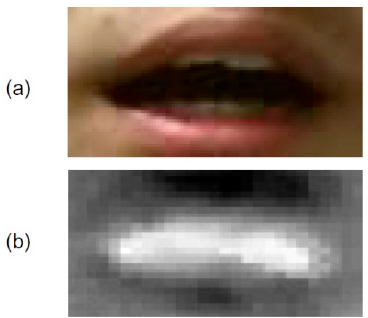
Figure 7. ( a ) Color and ( b ) depth images used for training in conventional methods [25] (Figure 3).